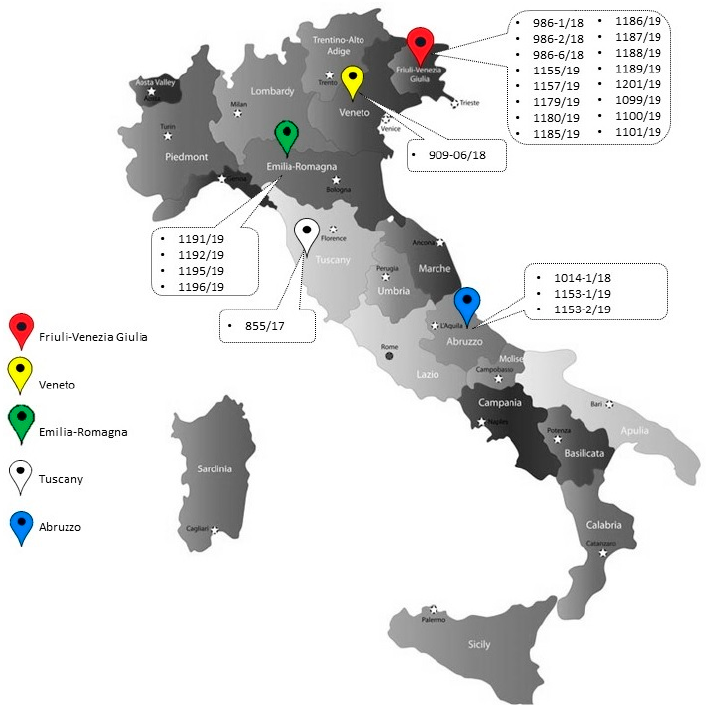
Figure 1. Distribution map of the CIAV strains detected in the study.